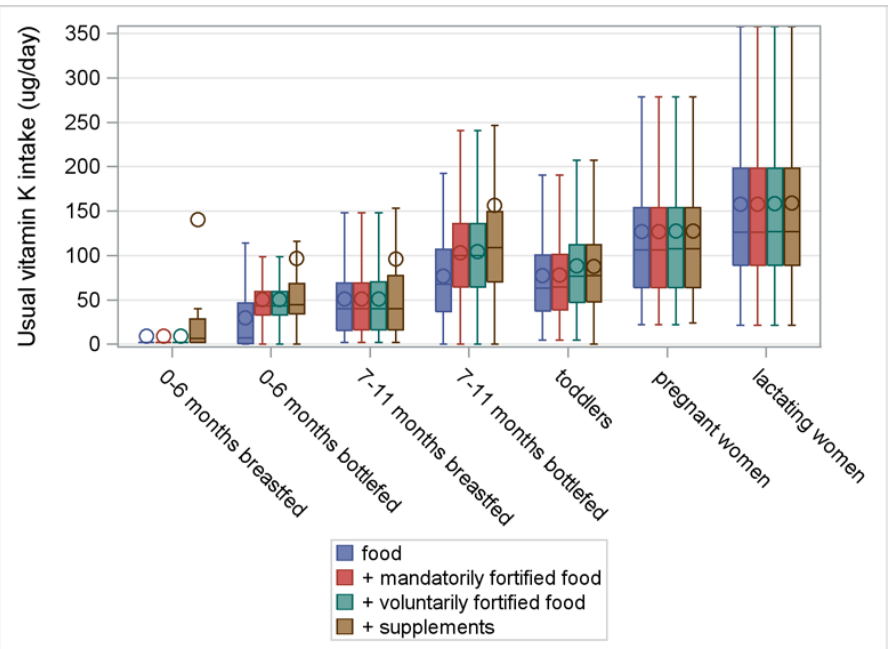
Figure 4. Usual intake of vitamin K (ug/day) from food, fortified food, and supplements in infants, toddlers, pregnant women, and lactating women from a Belgian study on the intake of vitamins A, D, E, and K (VITADEK-study) 2015.